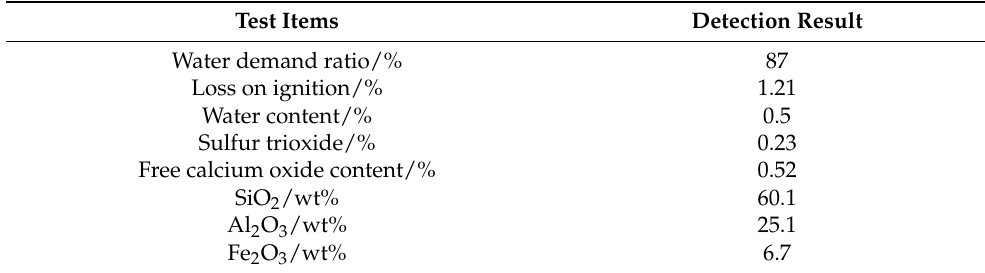
Table 4. The characteristic of fly ash